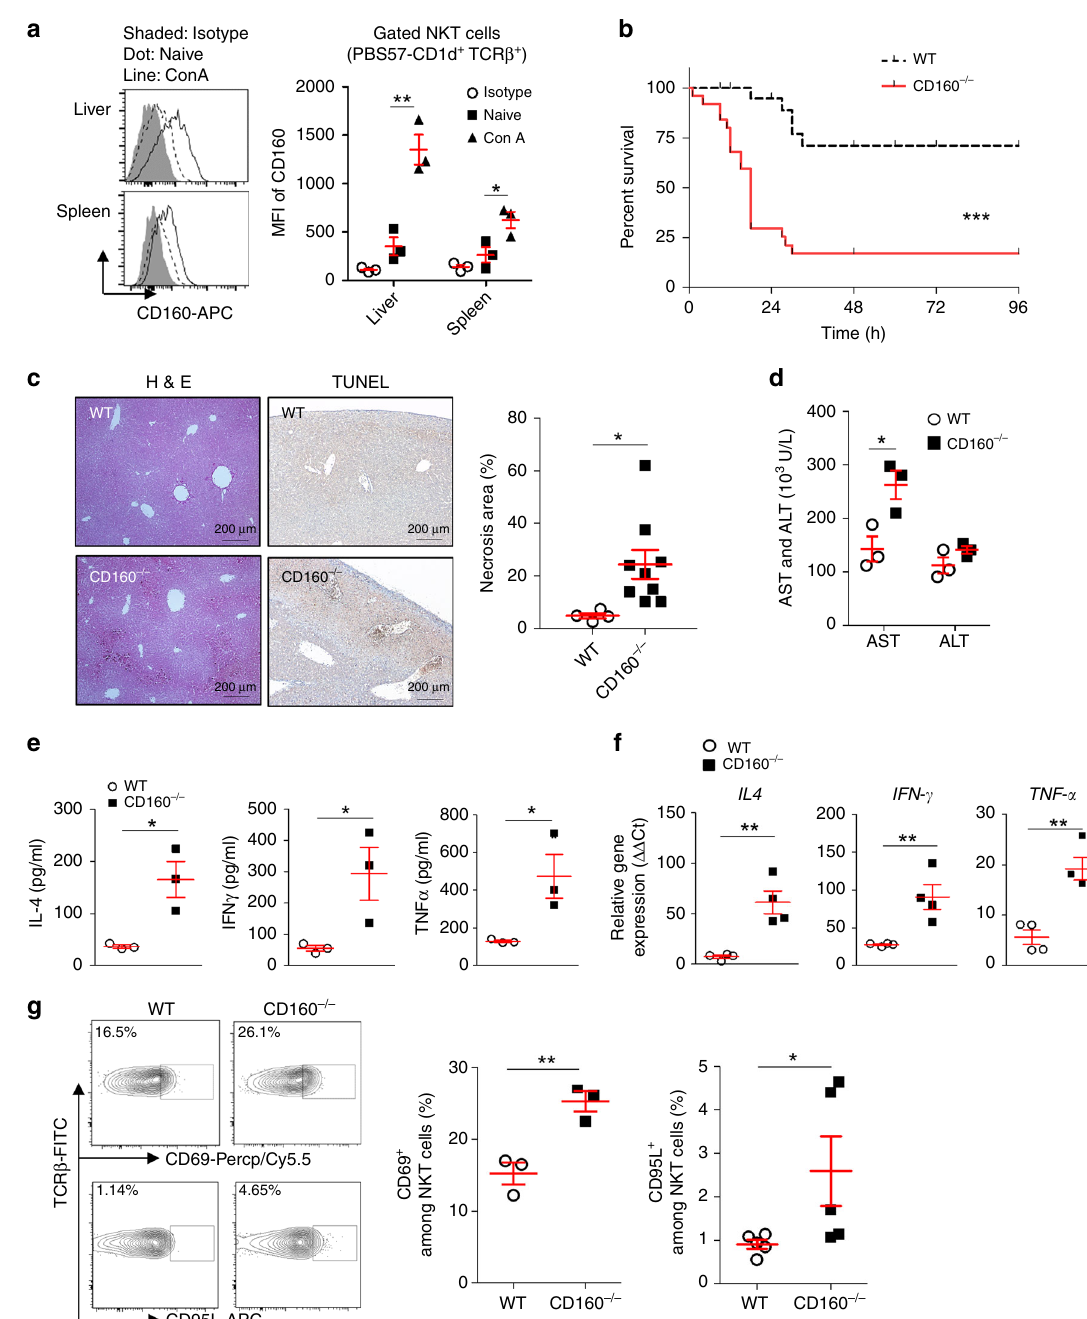
Fig. 7 Susceptibility to Con A-induced hepatitis in CD160 − / − mice. a Representative histograms showing CD160 expression in gated PBS57-CD1d tetramer + TCR β + NKT cells from the liver and spleen 4 h before and after i.v. injection with Con A (15 mg/kg). The graph represents average mean fl uorescence intensities (MFI) of CD160 expression of NKT cells from liver and spleen ( n = 3 per group). b WT and CD160 − / − mice were intravenously injected with Con A (30 mg/kg), and the rate of survival was recorded ( n = 21 – 25 per group). * P < 0.05, ** P < 0.01, *** P < 0.001 with a Log-rank (Mantel – Cox) Test. c The percentage of necrotic area and TUNEL ( + ) cells/ fi eld are shown as mean ± S.E.M. ( n = 4 – 9 per group). Scale bars: 200 μ m. d WT and CD160 − / − mice were intravenously injected with Con A (15 mg/kg), and serum was obtained to measure AST and ALT levels at 2 h ( n = 3 per group). e Analysis of serum levels of IL-4, IFN- γ , and TNF- α in WT and CD160 − / − mice 4 h after intravenous injection of Con A (15 mg/kg) by CBA and data presented as the mean ± S.E.M. ( n = 3 per group). f Quantitative RT-PCR analysis for IL-4, IFN- γ , and TNF- α mRNA levels in the livers of WT and CD160 − / − mice 4 h after intravenous injection of Con A (15 mg/kg). Gene expression was normalized to HPRT mRNA levels in each sample ( n = 4 per group). g Representative fl ow cytometry analysis showing expression of CD69 and CD95 Ligand in NKT cells from WT and CD160 − / − mice 4 h after Con A treatment (15 mg/kg). Graphs represent the percentage of the CD69 and CD95L positive portions in NKT cells among liver MNCs from WT and CD160 − / − mice ( n = 3 – 5 per group). All data are representative of three different experiments and presented as mean ± S.E.M. * P < 0.05, ** P < 0.01 with an unpaired two-tailed T -test